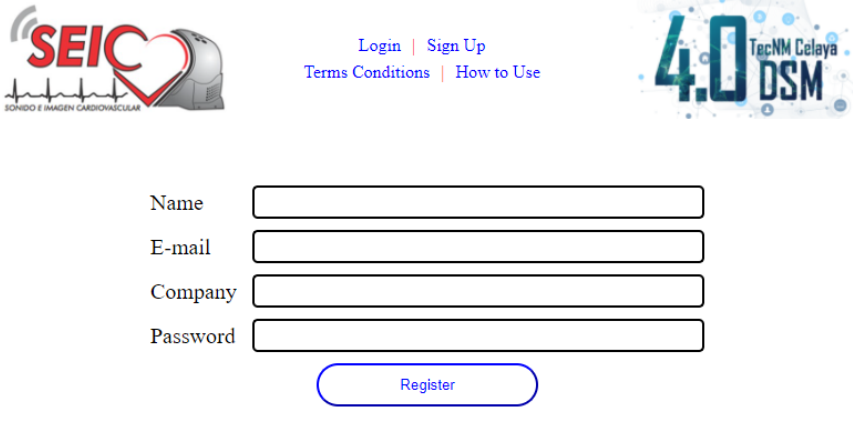
Figure 8. New user registration